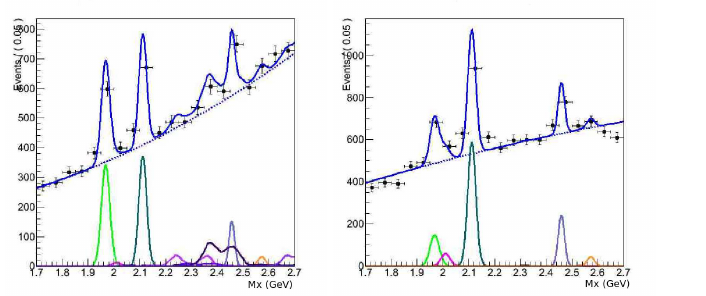
(left) and for s ( J )